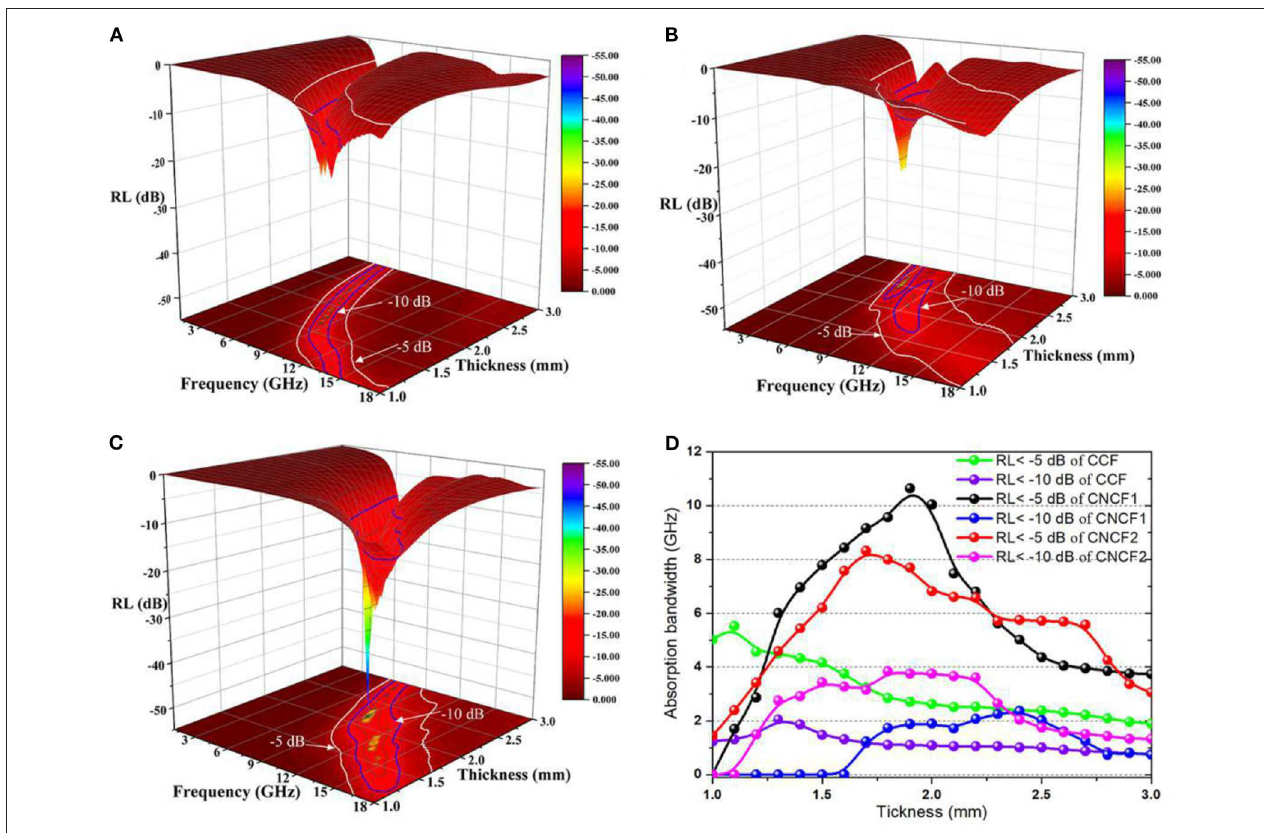
FIGURE 5 | Three dimensional representations of the RL of (A) CCF composites, (B) CNCF1 composites, and (C) CNCF2 composites with different thicknesses in the frequency range of 1.0–18.0 GHz, and (D) absorption bandwidth of composites with different thicknesses.